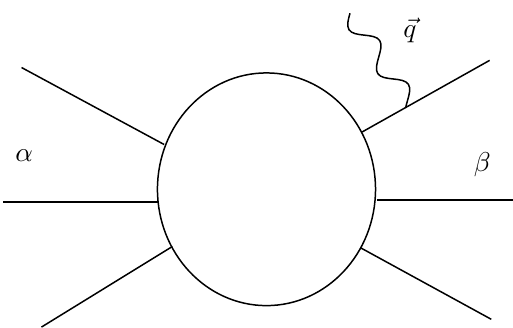
Figure 4. The soft limit of the scattering of phonons is dominated by diagrams within which the soft momentum is attached to an external